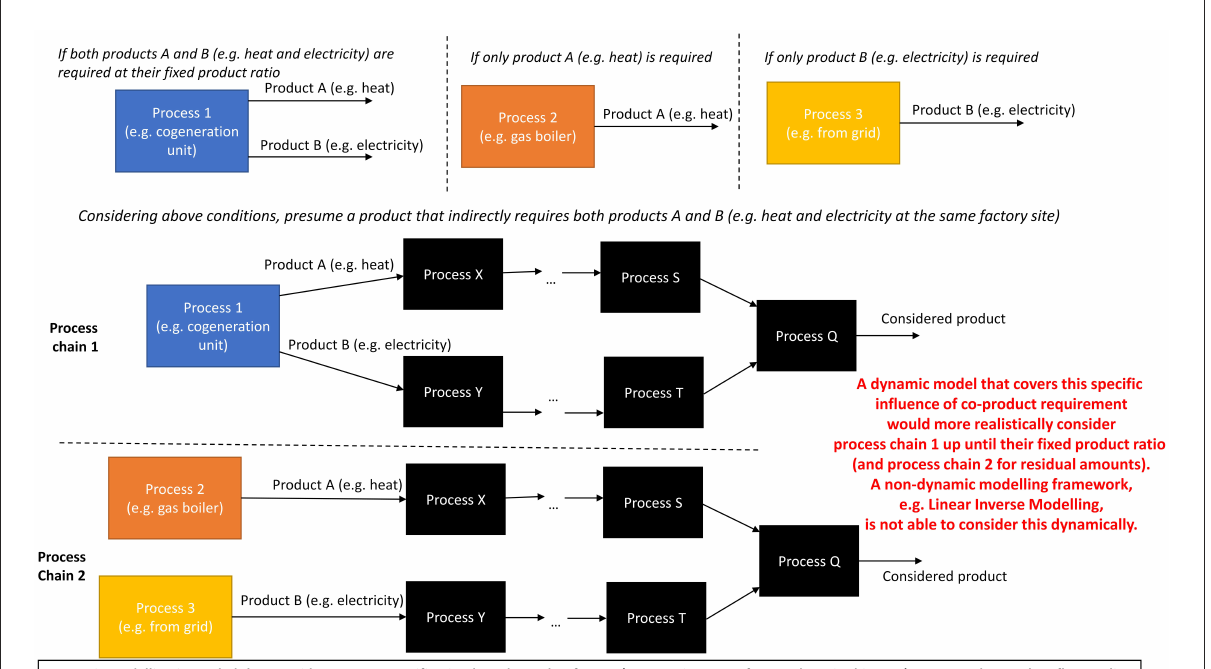
FIGURE1 Example on dynamic modeling in the case of selection of a certain process, which provides two co-products, instead of alternative processes, when both co-products are required in a certain fixed product ratio. Note that other types of dynamic effects